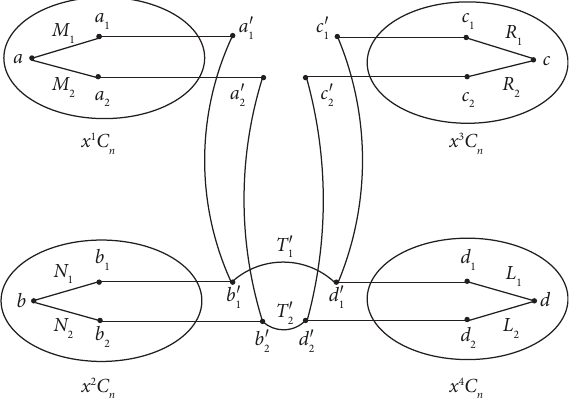
Figure 6: Te illustration of case 4 of Teorem